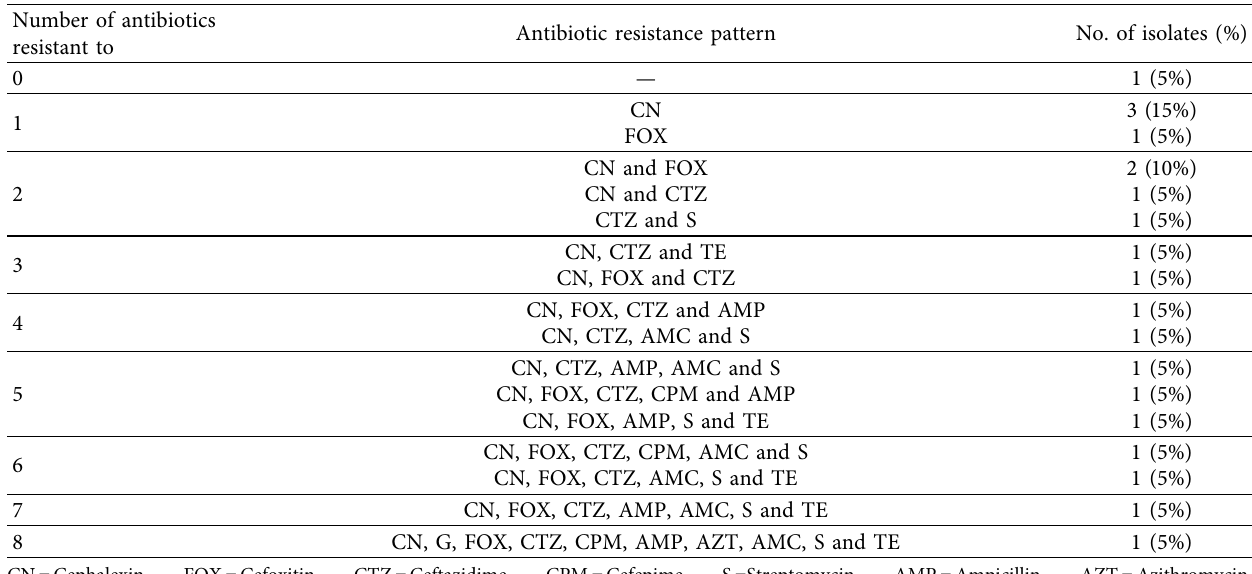
Table 7: Antibiotic resistance pattern showed by E. coli . isolated from milk and milk products from various outlets in Juja Sub-County,